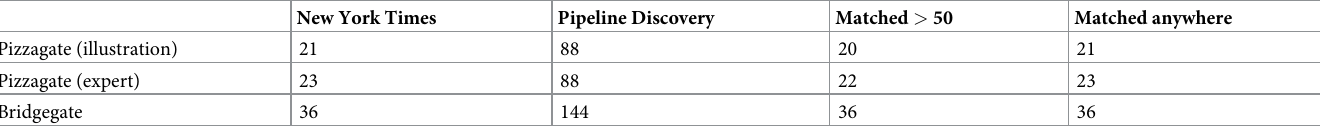
Table 3. Comparison of pipeline actant discovery with the gold standard evaluation data.